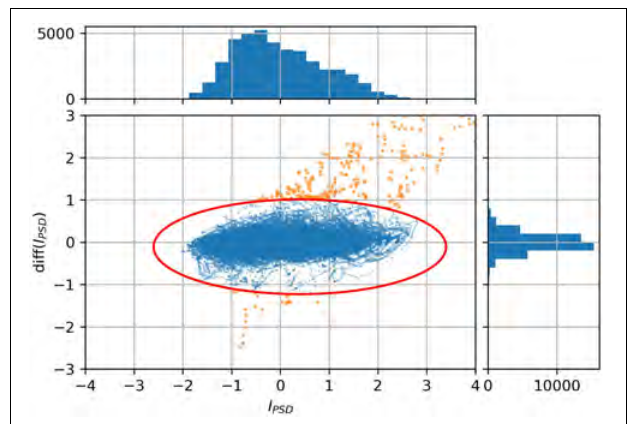
FIGURE 9 | Scatter plot and corresponding histograms of I PSD vs. diff(I PSD ). All points outside the ellipse, colored in orange, are identified as anomalies.